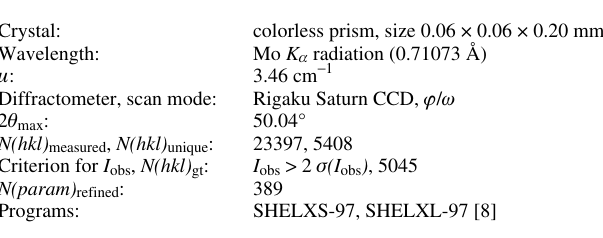
Table 1. Data collection and